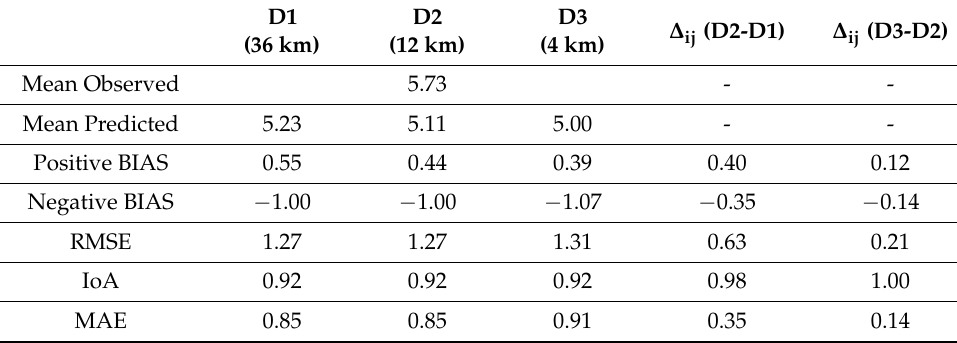
Table 5. Annual minimum temperature statistical analysis ( ◦